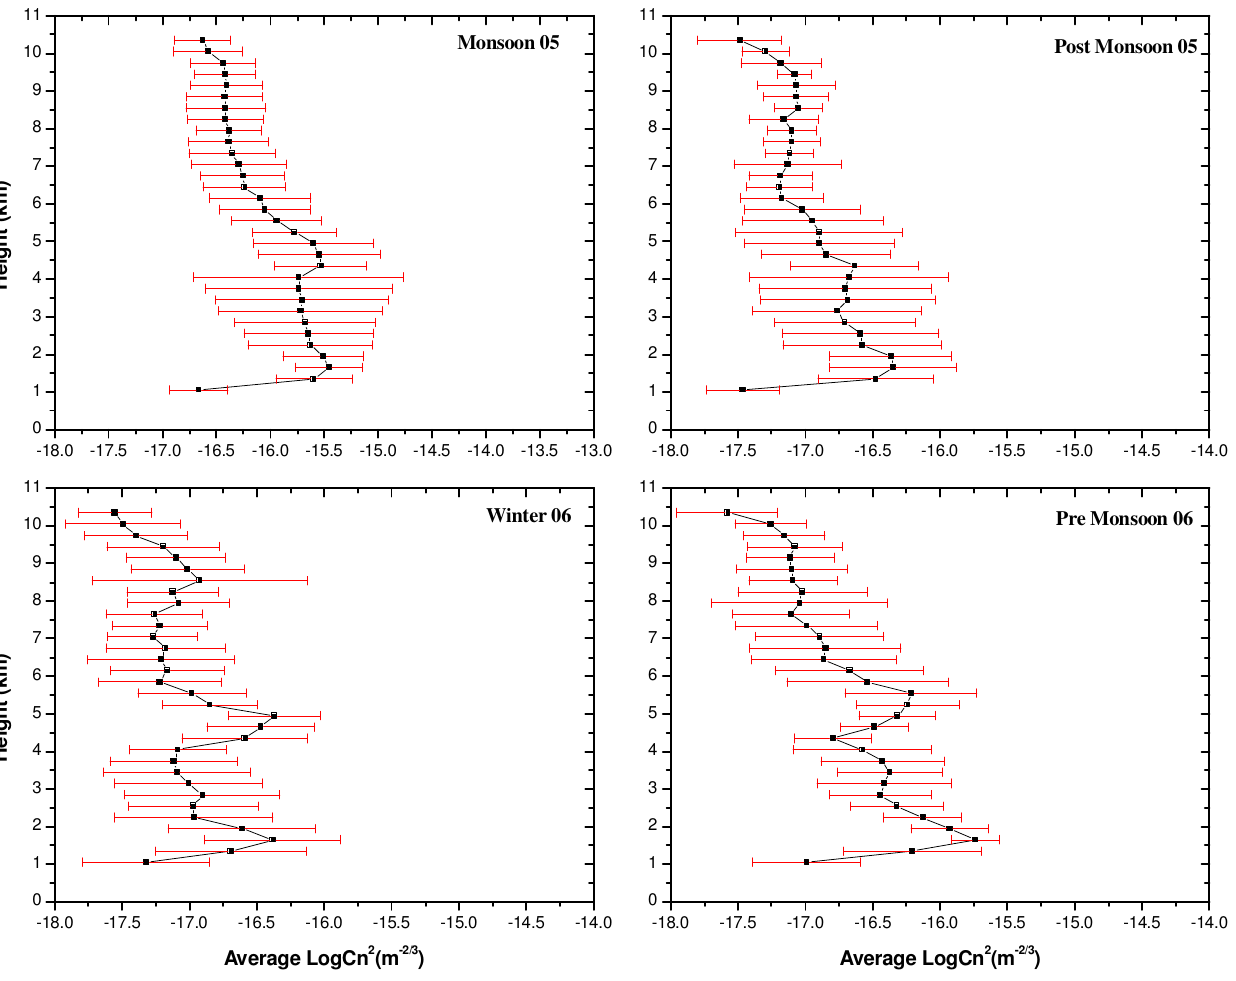
Fig. 4. Seasonal features with standard deviation, year 2005–2006. Total number of available data points for calculating seasonal mean and standard deviation are 95 (for monsoon 2005, the upper left panel), 78 (for post-monsoon 2005, upper right panel), 53 (for winter 2006, bottom left panel), and 57 (for pre-monsoon 2006, bottom right